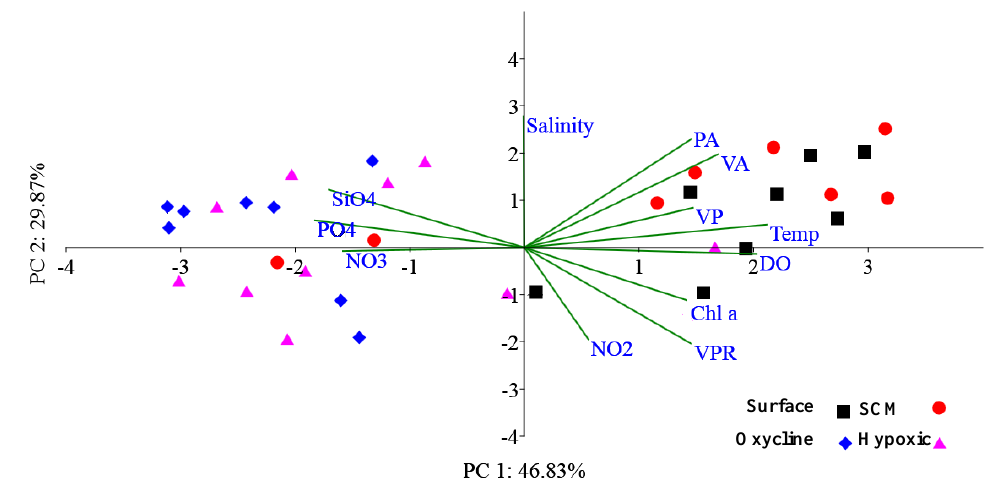
Figure 4. Principal coordinate analysis showing the inter-relationship between with various biotic and abiotic variables. The sampling depths are represented as different colour patterns. Abbreviations used: viral abundance (VA), prokaryotic abundance (PA), virus to prokaryote ratio (VPR), viral production (VP), Chlorophyll a (Chl), dissolved oxygen (DO), temperature (Temp), nitrate (NO 3 ), Nitrite (NO 2 ), Phosphate (PO 4 ), and silicate (SiO 4 ). The percentage variance explained by PC1 is 46.83% and PC2 is 29.87%. Table 3. Results of the DistLM (non-parametric distance-based linear regression analysis) for understanding the effects of physico-chemical parameters on biological variables explaining VA. Variable SS F P Pc Prop. DO